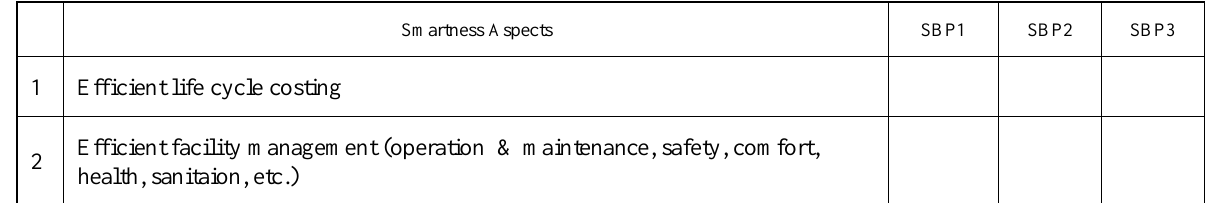
Table 2.SBP Smartness Aspects Checklist; Source: Authors Based on Literature